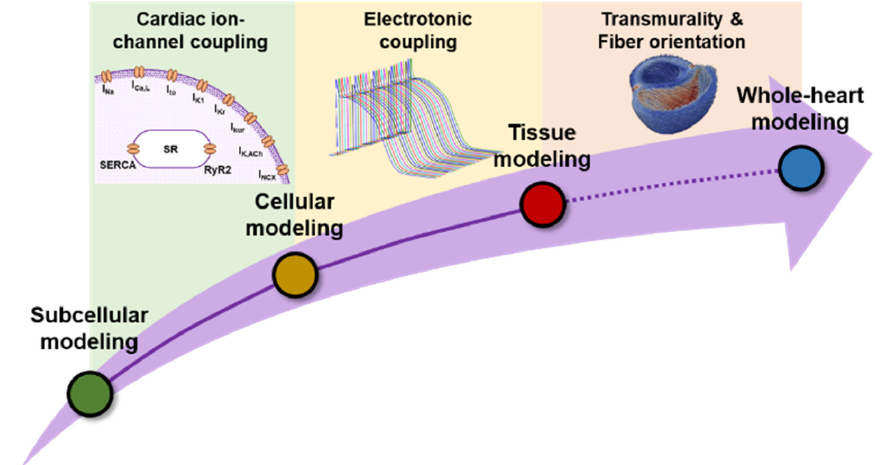
Figure 3. Schematic illustration of multiscale computational modeling. To integrate individual modeling scales into a holistic model, a subcellular model of cardiomyocyte calcium handling is coupled with other cardiac ion channels to form a cellular model. Subsequently, cell models propagate the electrical impulse through gap junctions to form a 1-dimensional strand or 2-dimensional tissue model. At the organ level, different types of tissues, representing different regions and layers of the heart (e.g., epicardium, mid-myocardium, endocardium, Purkinje fibers, etc.) are combined with fiber orientation and structural remodeling.